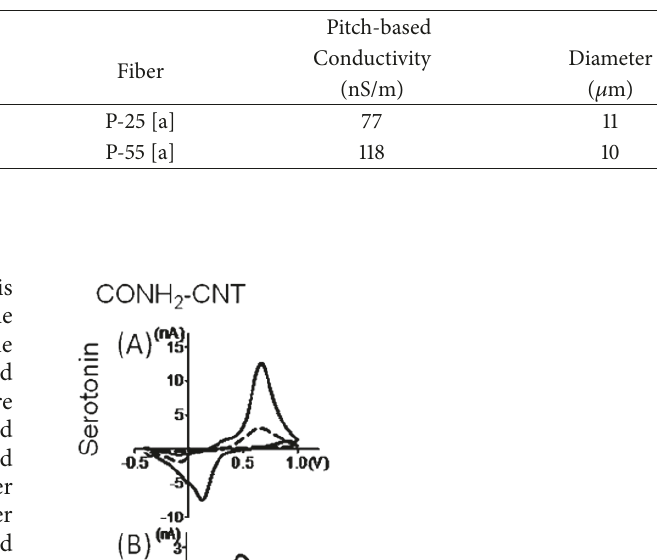
Table 2: Conductivity and diameter of carbon fibers. The table is reproduced with permission from [9].